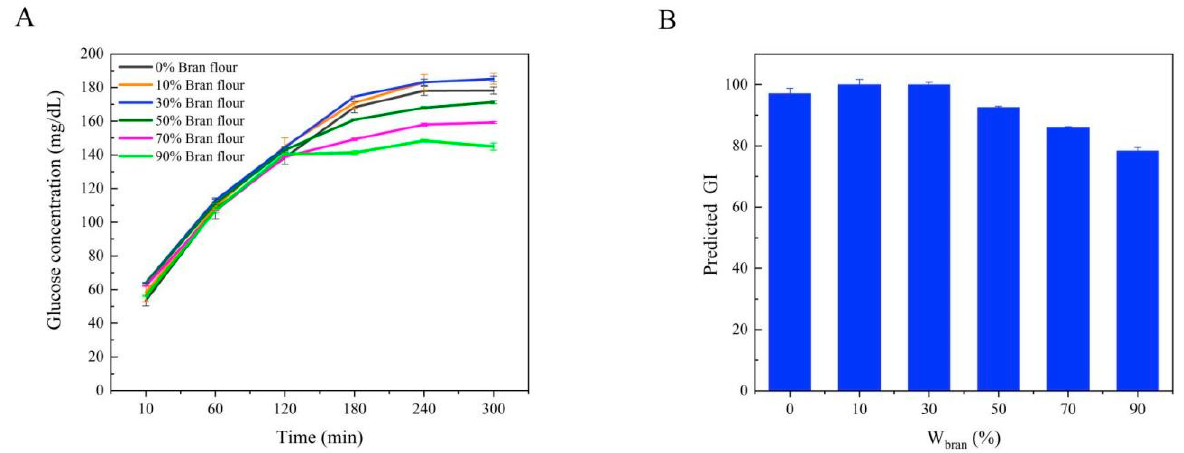
Figure 8. Effect of Wbran on the starch hydrolysis ( A ) and predicted GI value ( B ) of steamed bread (W bran : the weight proportion of TBBF in the blend four).